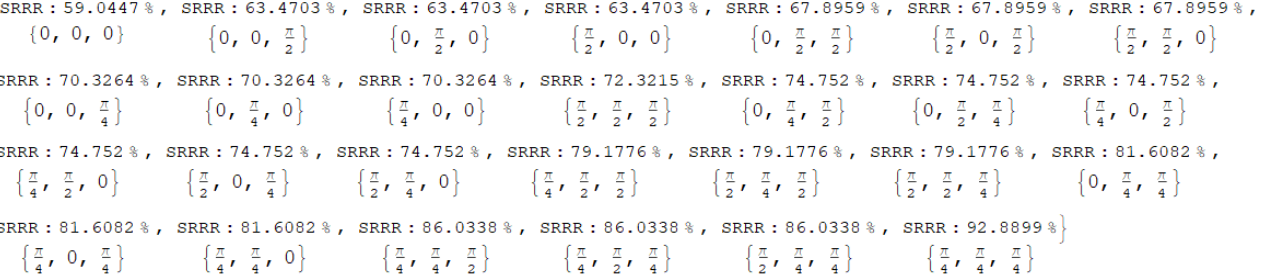
Figure 6. Solar Radiation Reception Rate for m = 2 and n = 2 at the equinox in the region of Makkah, Saudi Arabia. Figure 8. Solar Radiation Reception Rate for m = 2 and n = 2 at the winter solstice in the region of Makkah, Saudi Arabia.